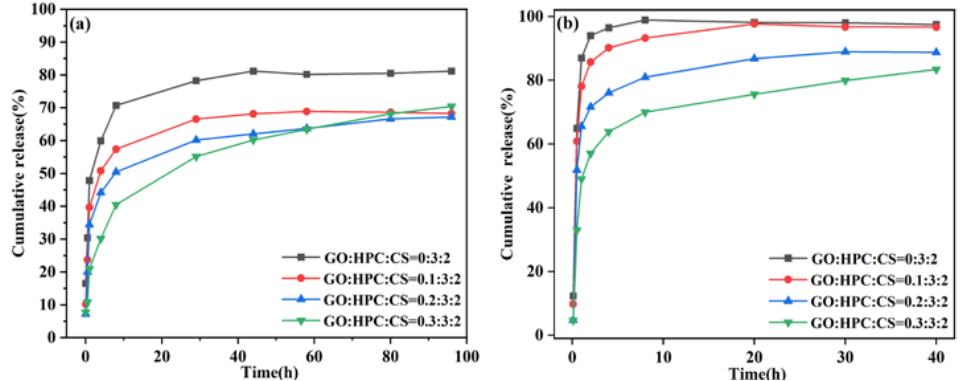
Figure 7. Cumulative release of 5-Fu under ( a ) pH = 7.4 and ( b ) pH = 5.0.